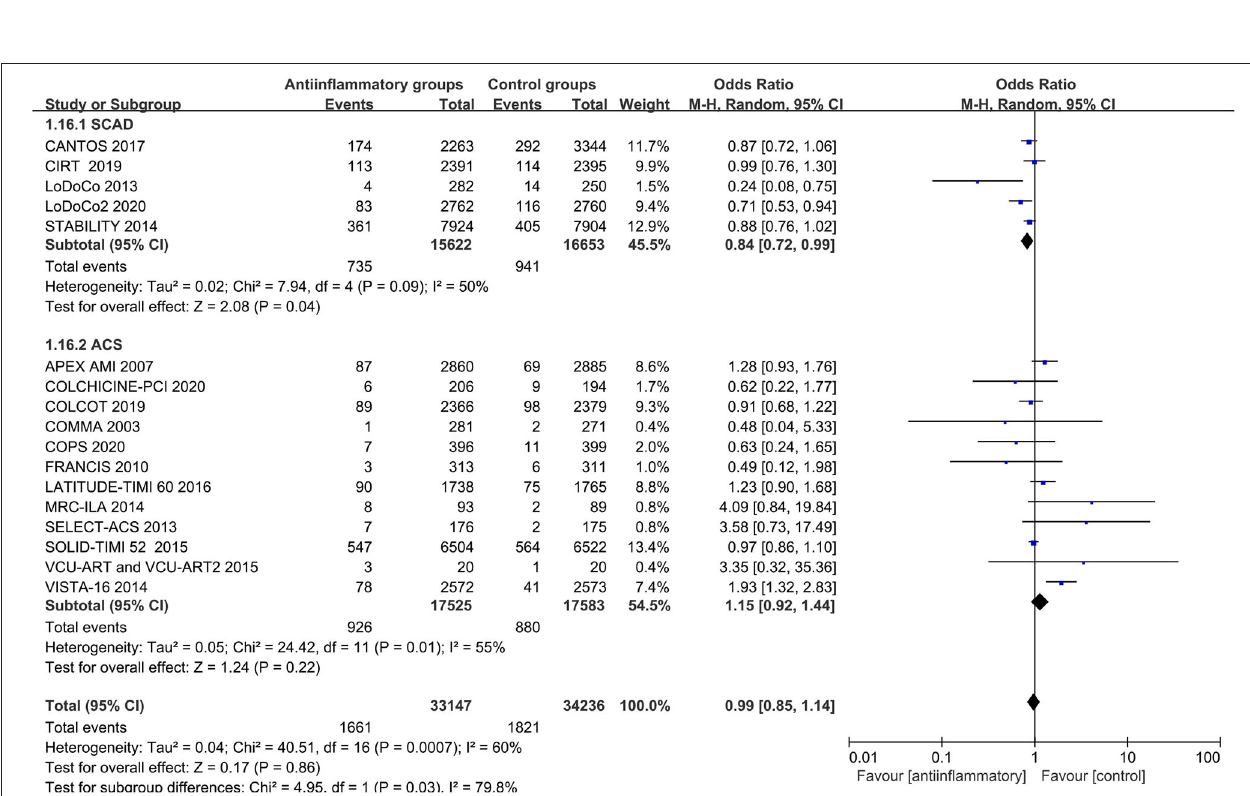
Frontiers in Cardiovascular Medicine |